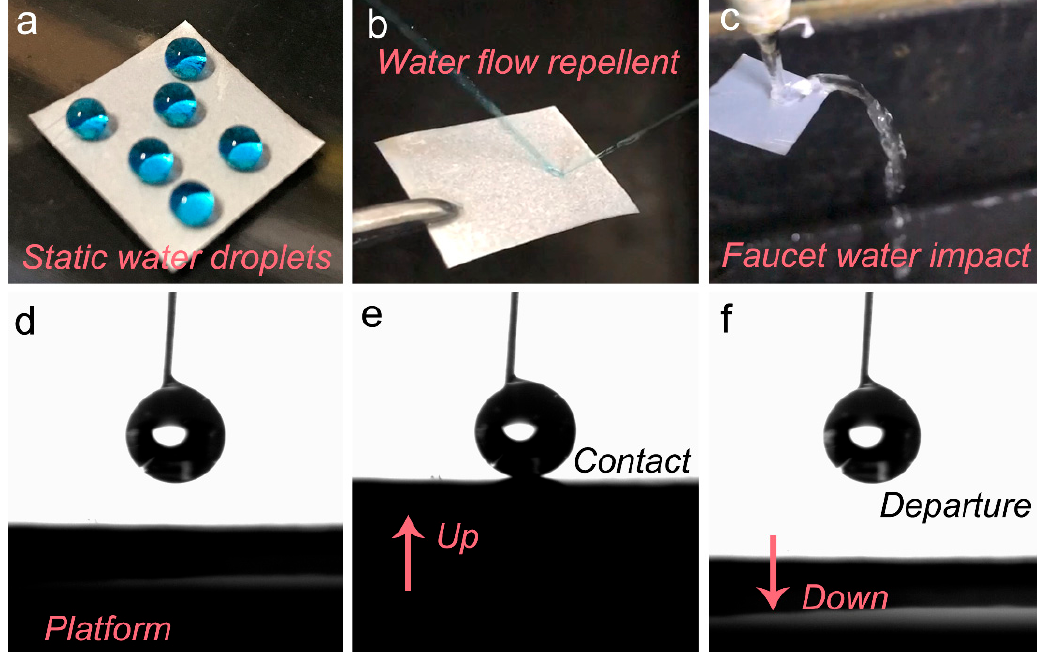
Figure 4. Optical images of the as-prepared superhydrophobic AA5083 surface ( a ) with spherical water droplets, ( b ) with a jet of water flow, ( c ) with faucet water impact, and ( d – f ) with platform movement to contact and departing of the water droplet.